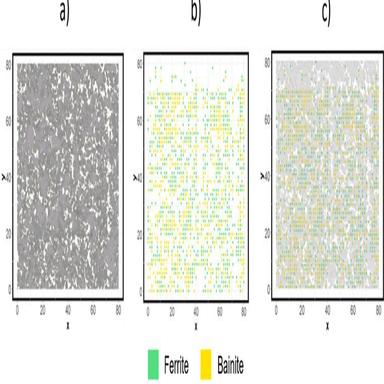
(a) Isolated EBSD map of the bainite and ferrite region, (b) scatter map of the nanoindentation Bainite and Ferrite region, and (c) combined nanoindentation and EBSD map of Bainite and Ferrite region.